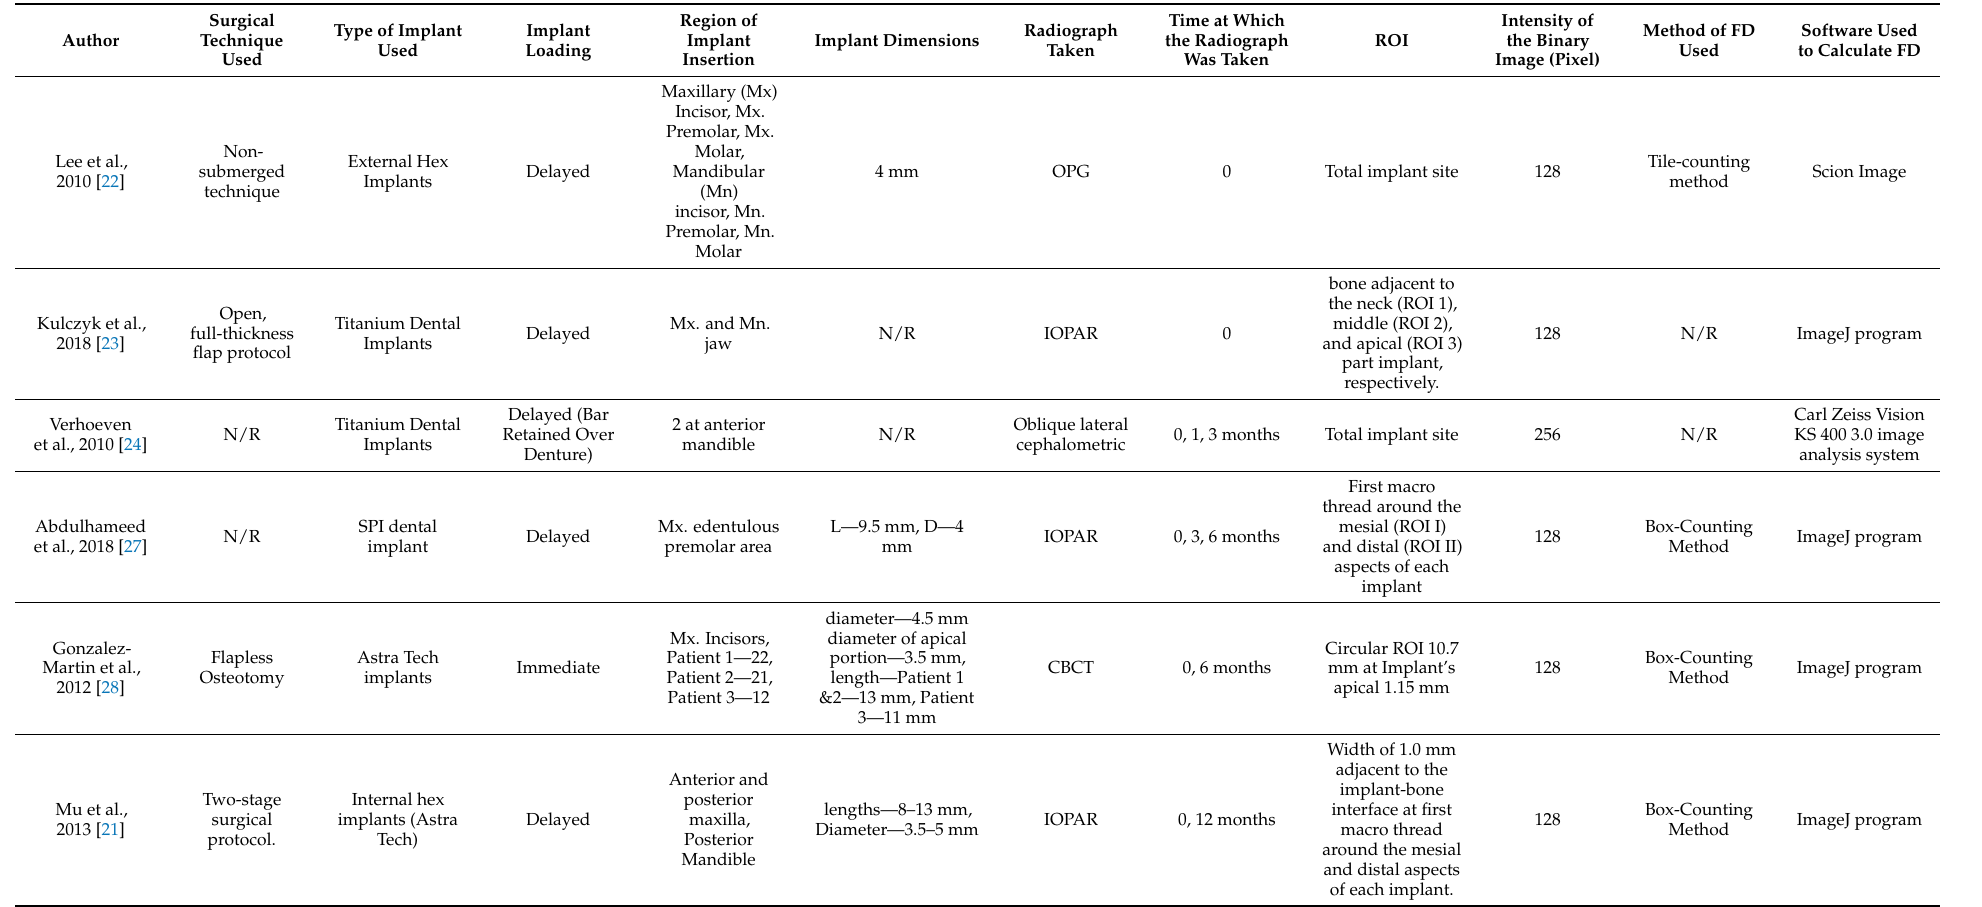
Table 3. Interventional characteristics of the included